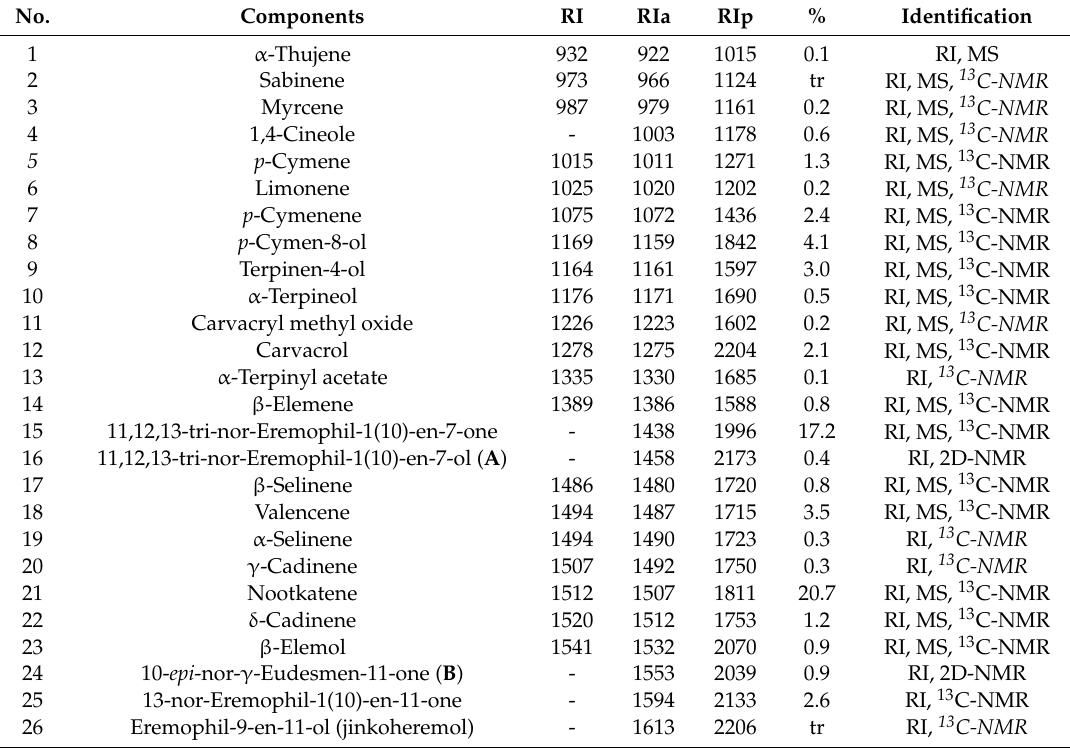
Table 1. Chemical composition of Xanthocyparis vietnamensis wood